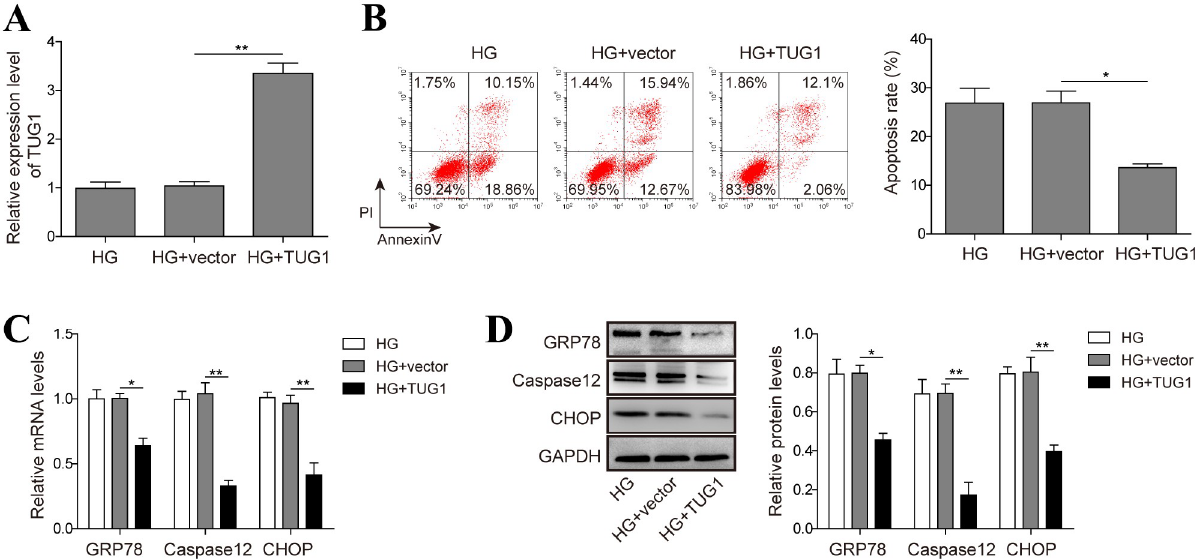
Fig 2. TUG1 decreases high glucose (HG)-triggered apoptosis and ERS in HK-2 cells. (A) HK-2 cells were transfected with empty vector or TUG1 overexpression vector, mRNA level of TUG1 was evaluated by real-time PCR. (B) HK-2 cells transfected with indicated vectors were challenged with 30 mM D-glucose for 48 h, cell apoptosis was examined by flow cytometry. (C, D) HK-2 cells were challenged with D-glucose, the levels of GRP78, caspase12 and CHOP were examined by real-time PCR and western blot. Data were mean ± SD and were representative of three independent experiments. � p < 0.05, �� p <